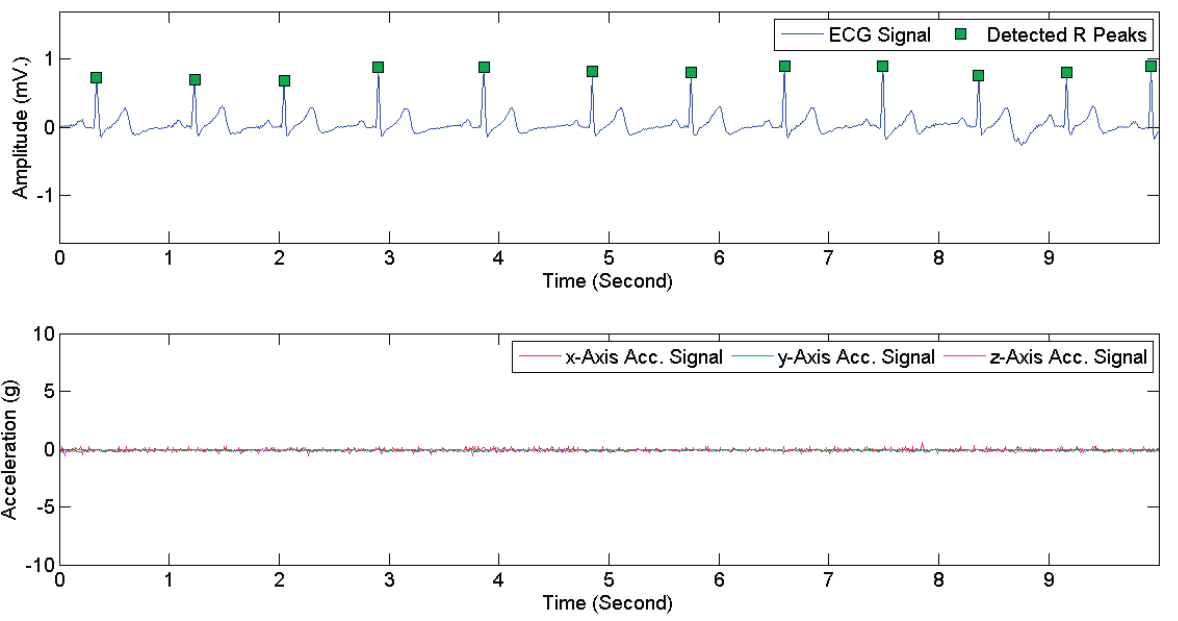
Figure 7. ECG signals ( Above ) and 3D acceleration signals ( Below ) when a subject was sitting.